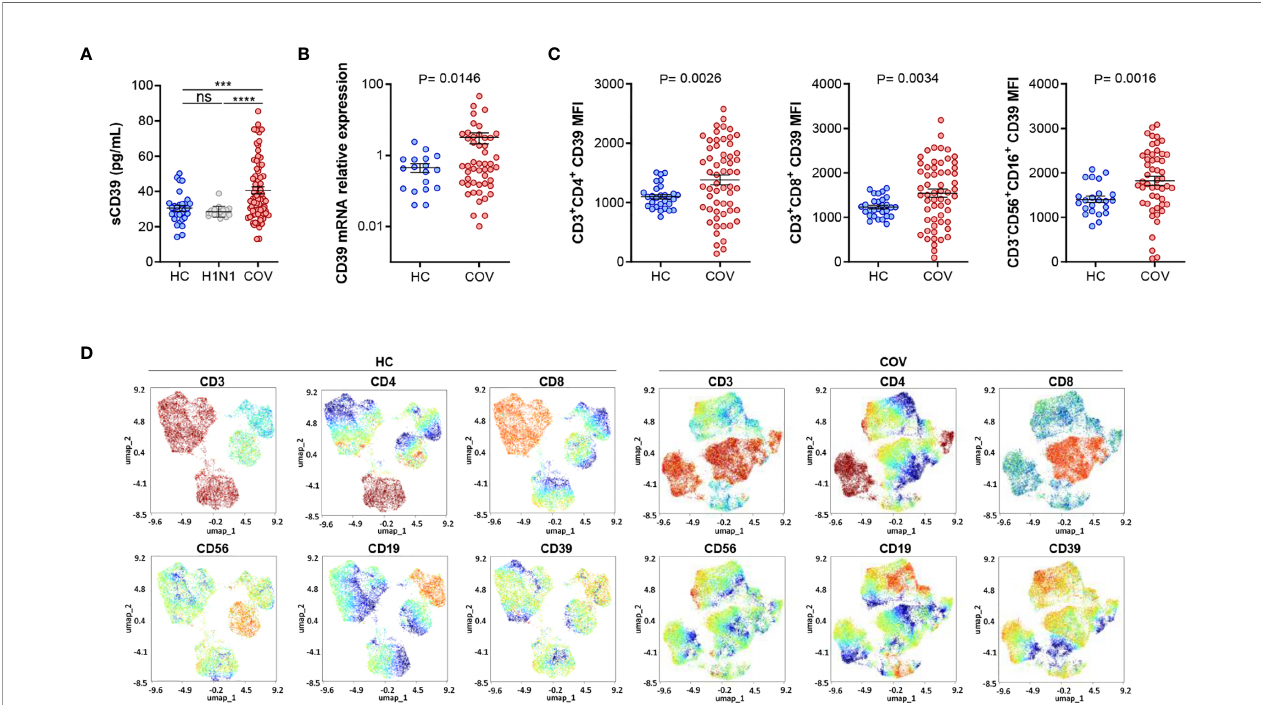
FIGURE 1 | Elevated CD39 expression in COVID-19 patients. (A) ELISA quanti fi cation of soluble CD39 (sCD39) plasma levels in healthy controls (HC, n=30), in fl uenza A patients (H1N1, n=18) and COVID-19 patients (COV, n=75). (B) CD39 mRNA expression analysis by qPCR in PBMCs from healthy controls (HC, n=22) and COVID-19 patients (COV, n=51). (C) Analysis of CD39 expression by fl ow cytometry on CD3 + CD4 + and CD3 + CD8 + T lymphocytes from total PBMCs of healthy controls (HC, n=29) and COVID-19 patients (COV, n=58) and CD3 - CD56 + CD16 + NK cells (HC, n=23; COV, n=51). CD39 expression is represented by MFI (Mean Fluorescence Intensity). Mean differences were analyzed using unpaired Student ’ s t-test analysis with Welch correction. Error bars: mean ± SEM. ***P < 0·001; ****P < 0·0001. (D) UMAP-guided manual gating analysis of general immune cell lineages. Healthy control PBMCs sample (HC, left panel) and COVID-19 PBMCs sample (COV, right panel). ns, non signi fi